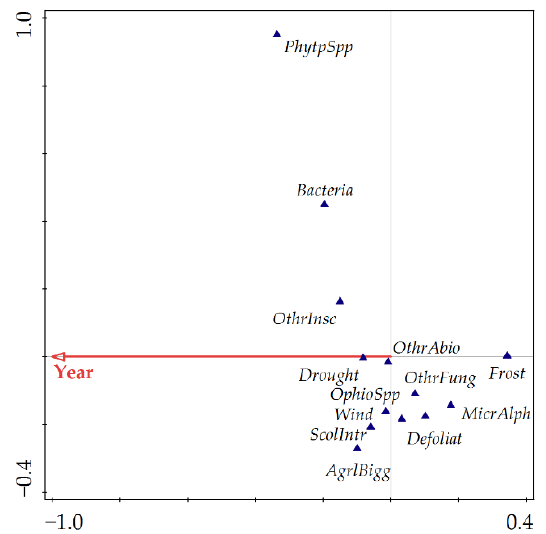
Figure 6. Chronology of cited factors in oak decline episodes over time (1739 – 2020), (pF = 35.4 p < 0.002). CCA = canonical correspondence analysis (CANOCO 5).